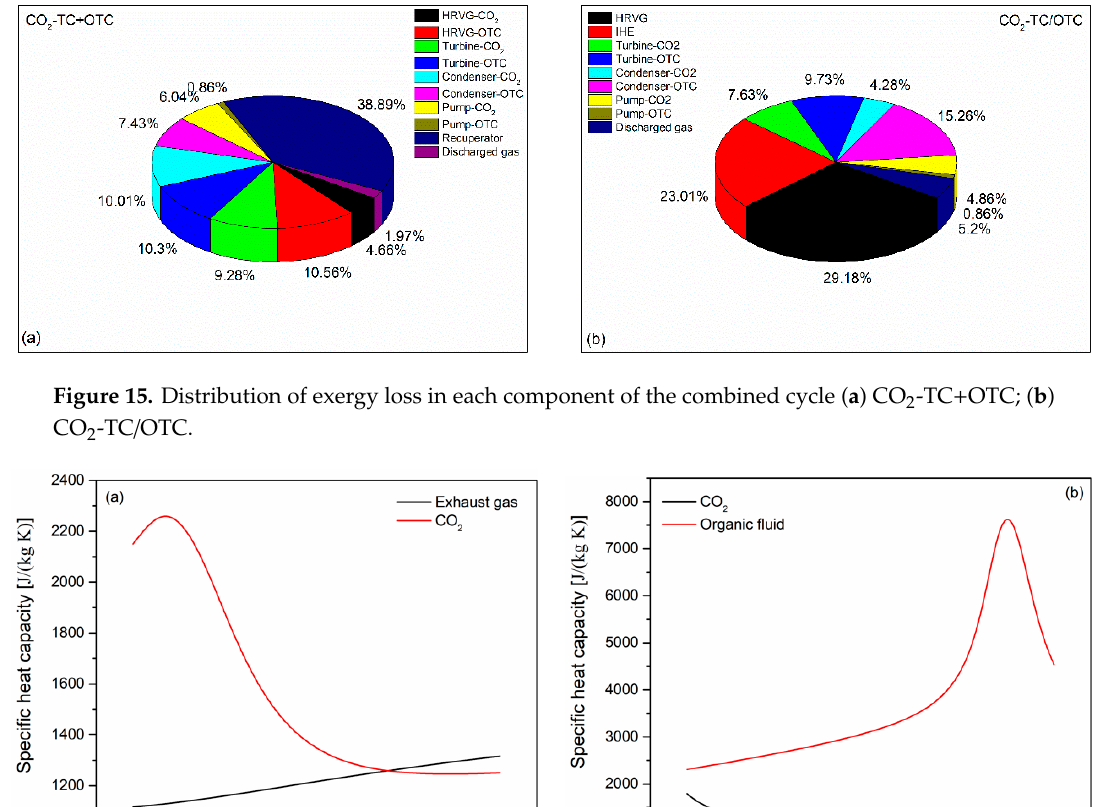
Figure 16. Variation of specific heat capacity of fluids in ( a ) HRVG; ( b ) IHE for CO 2 -TC/OTC.